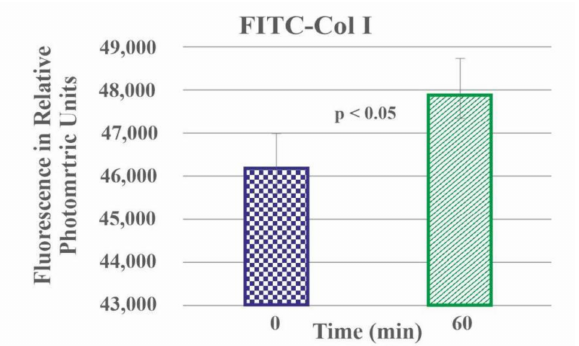
Figure 4. De-quenching of FITC-Col I in the presence of CH collagenase for 1 h at 37 ◦ C.